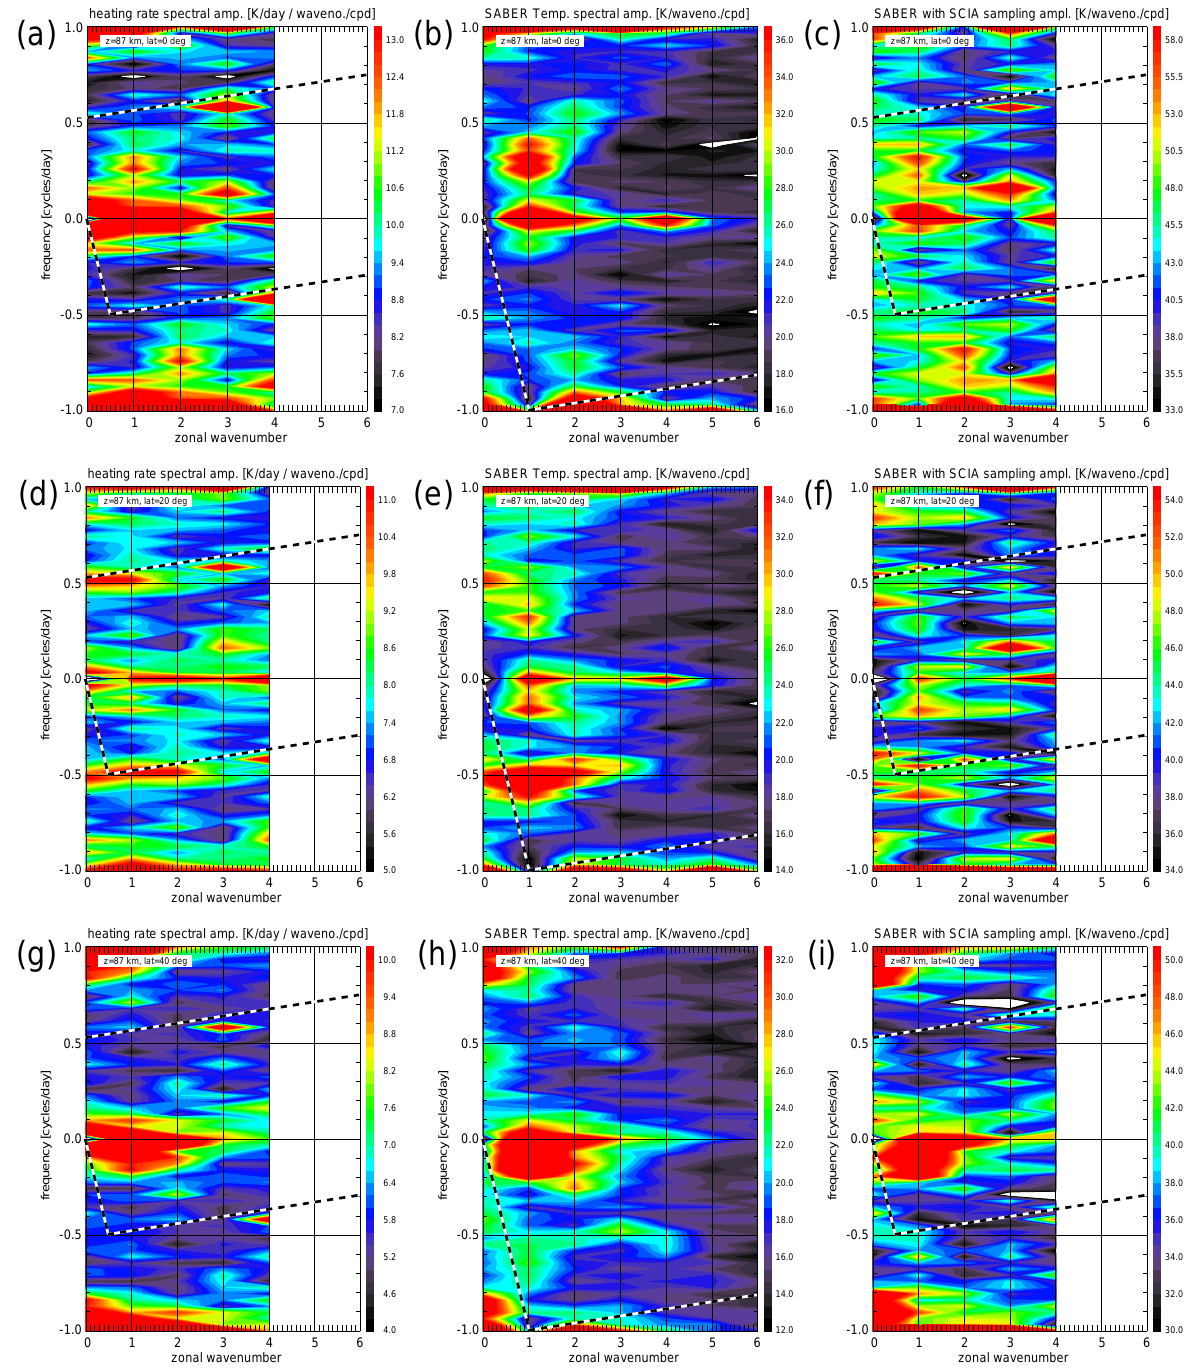
Fig. 2. Space-time spectra averaged over the period 2002–2006 of residual SCIAMACHY heating rates at 87km altitude at the equator (a) , 20 ◦ N (d) and 40 ◦ N (g) . Positive frequencies denote eastward and negative frequencies westward traveling waves, respectively. For comparison also average space-time spectra of residual SABER temperatures are shown at 87km altitude at the equator (b) , 20 ◦ N (e) and 40 ◦ N (h) , as well as “artificial” space-time spectra obtained by sampling the SABER analysis with SCIAMACHY measurement locations and times for the same latitudes ( c , f , and i ). The spectral range that can be resolved unambiguously by the SCIAMACHY and the SABER sampling are rectangles rotated with respect to the zonal wavenumber/frequency coordinates. The boundaries of these rectangles falling into the zonal wavenumber/frequency range shown in Fig. 2 are indicated as black and white dashed lines. Due to the single node sampling the spectral range resolved by the SCIAMACHY hydroxyl nightglow data is only half the